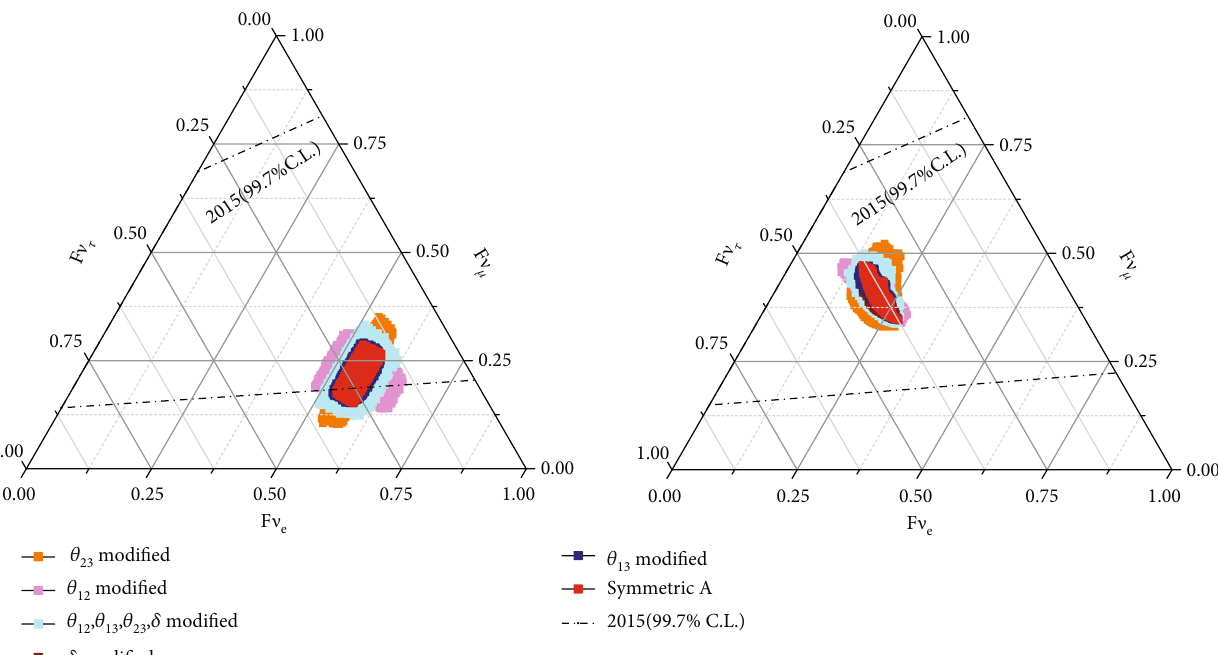
Figure 4: The fl avor ratio at Earth. (a) is for the neutron-decay source ð 1, 0, 0 Þ . (b) is for the muon-damping source ð 0, 1, 0 Þ . Except for the light cyan region, the conventions of the mixing parameters are the same as those in Figure 2. The light cyan region corresponds to the case that all the mixing parameters are modi fi ed in U S . The speci fi c ranges for the modi fi cations are listed as Δ s 2 13 ∈ ½ − 0 : 01,0 : 01 (cid:2) , Δ s 2 12 ∈ ½ − 0 : 1,0 : 1 (cid:2) , Δ s 2 ∈ ½ − 0 : 1,0 : 1 (cid:2) , and Δδ ∈ ½ − 0 : 5,0 : 5 (cid:2) radian. The red region corresponds to the prediction of the standard matrix A . The 3 σ constraint on 23 CP the fl avor ratio is from the 2015 IceCube data [53].